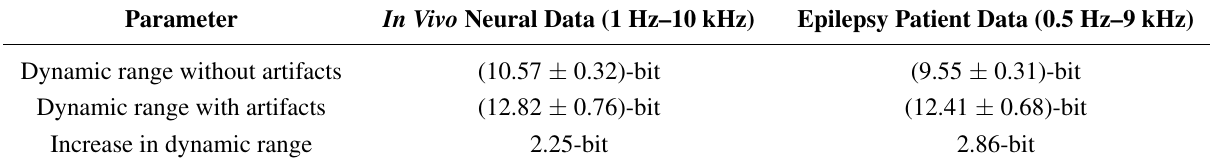
Table 1. Averaged data dynamic range of in vivo neural activities.